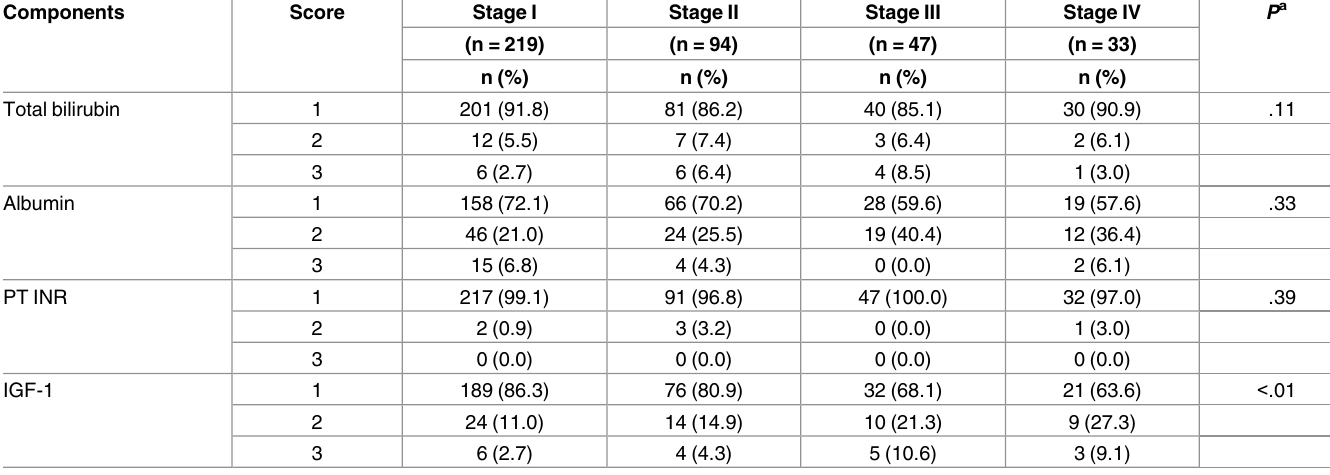
Table 5. Results from nonparametric trend analysis evaluating possible trends between AJCC stage and each parameter of IGF-CTP classification.